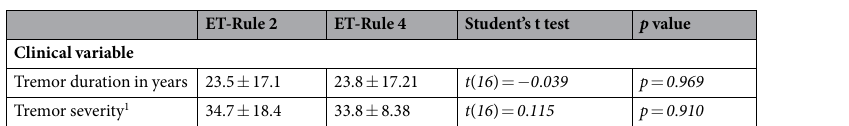
Table 9. Clinical variables of the ET groups defined by the rule model. Values are expressed as mean ± standard deviation. 1 Fahn–Tolosa–Marin Tremor Rating